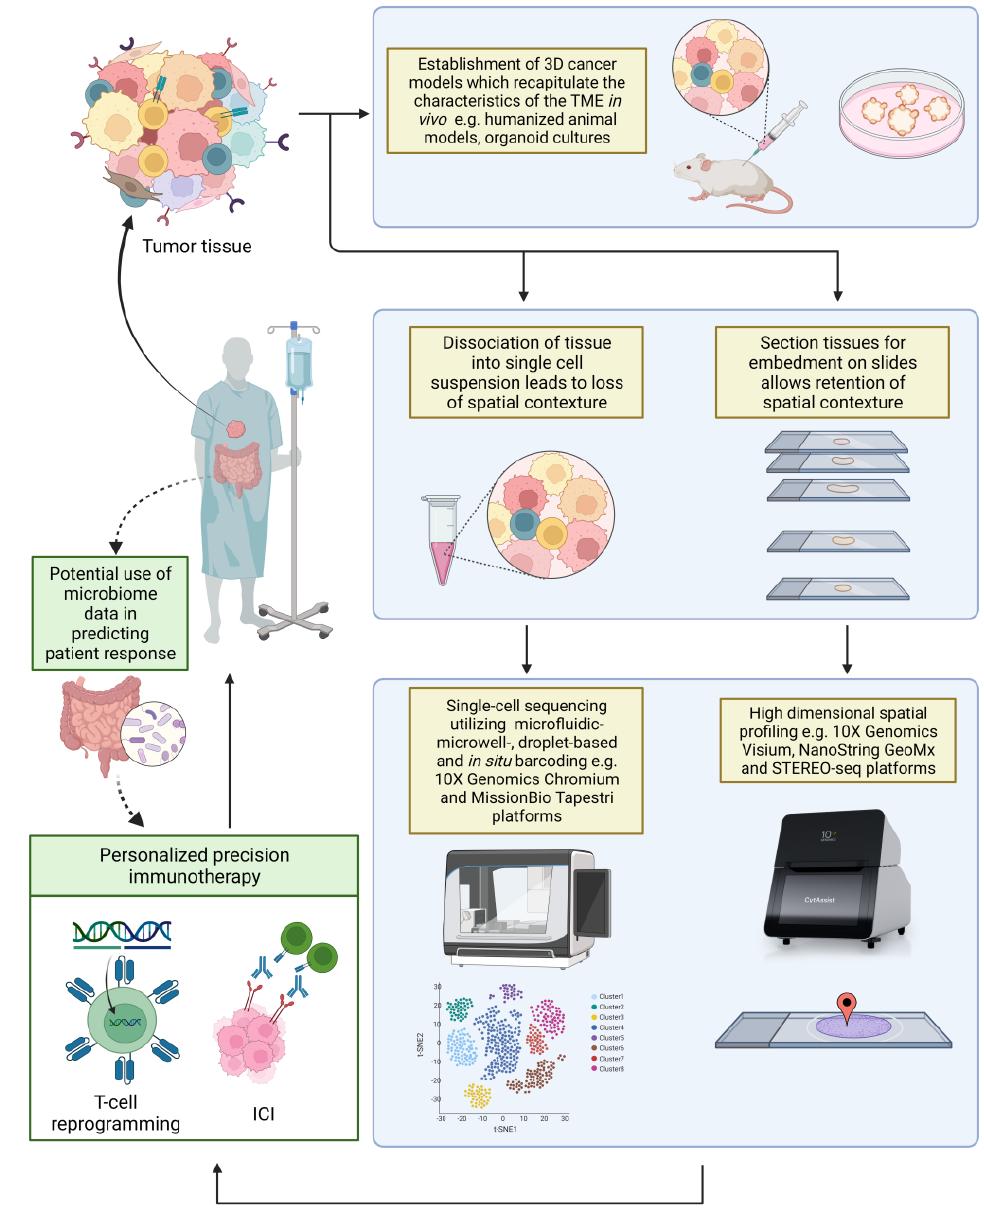
Figure 2. Emerging high-dimensional technologies in the field of immune-oncology.